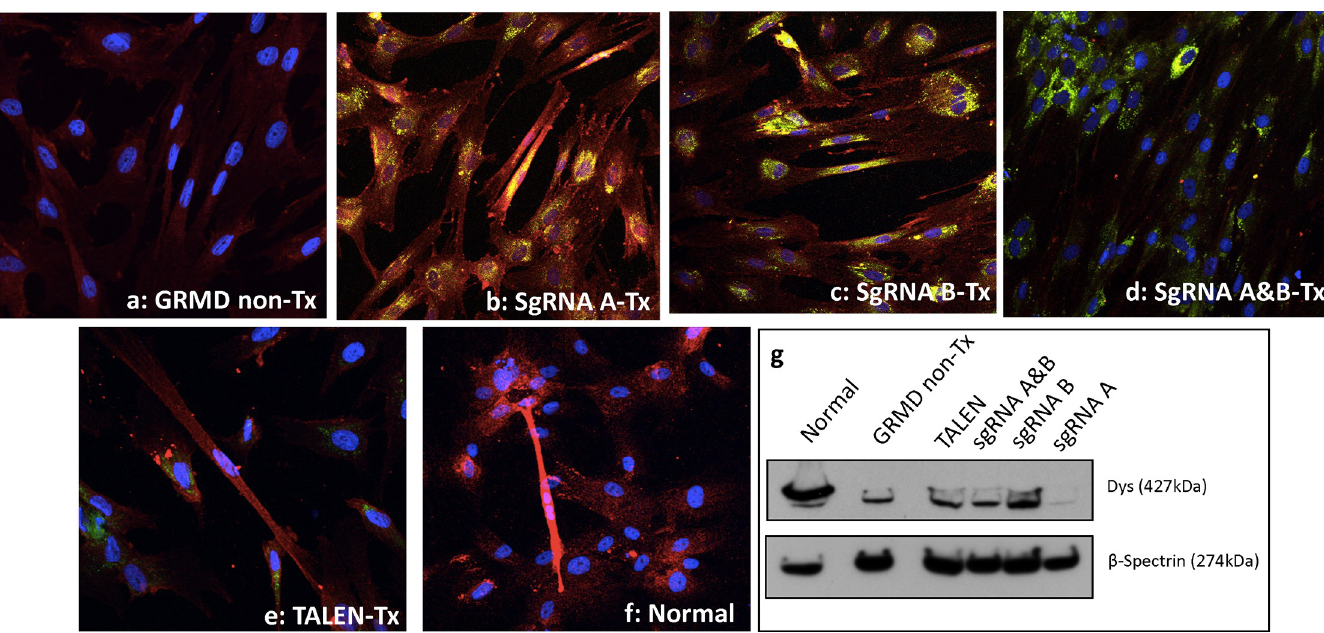
Fig 3. Dystrophin protein immunostaining and western blot from HDR- treated (Tx) and non-Tx myotubes. Dystrophin co-stained with C and N-terminus antibodies, Alexa 647 (red) and DAPI stained nuclei (blue). EGFP from the cells treated with donor clone (green) and mCherry from the sgRNA/Cas9 clones (yellow) indicate expression of plasmid proteins in the cell. All images were taken with the 20X objective; only multinucleated, elongated myotubes were used for quantification. (a) GRMD non-Tx myotubes showed background signal for Alexa 647. (b) sgRNA A-Tx and (c) B-Tx GRMD myotubes had increased dystrophin. (d) GRMD myotubes sgRNA A&B-Tx, (e) TALEN-Tx GRMD myotubes, and (f) normal myotubes. (g) Western blot from protein extracted from treated and non-Tx myotubes. Dystrophin co-stained with C and N-terminus antibodies and β -spectrin was used as a loading control.